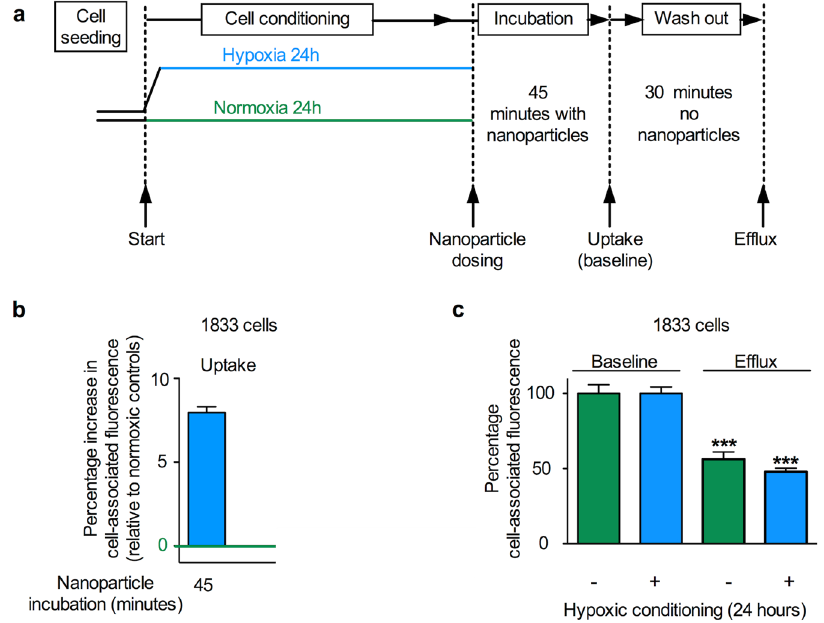
Figure 5. Impact of hypoxic preconditioning on the uptake (endocytosis) and recycling (exocytosis) of nanoparticles by human 1833 breast cancer cells. ( a ) Diagram of the experimental approach. Cells were conditioned in hypoxia (1% O 2 ) for 24 hours and then dosed with nanoparticles at a concentration of 1 × 10 11 nanoparticles/ml for 45 minutes. For the recycling studies, cells were preconditioned for 24 hours in either hypoxia (1% O 2 ) or normoxia. Next, cells were similarly dosed for 45 minutes and analysed (baseline) or washed and allowed to exocytose for 30 minutes (exocytosis) ( b ) Cell uptake of fluorescent nanoparticles was assessed by measuring mean single cell-associated fluorescence by flow cytometry. ( c ) Exocytosis of fluorescent nanoparticles of normoxia or hypoxia preconditioned cells. Mean single cell-associated fluorescence was measured by flow cytometry, ≥ 10,000 events per measurement; ( b ) n = 15 from 3 independent biological experiments, ( c ) n = 20 for each treatment period, 2 independent biological experiments ±